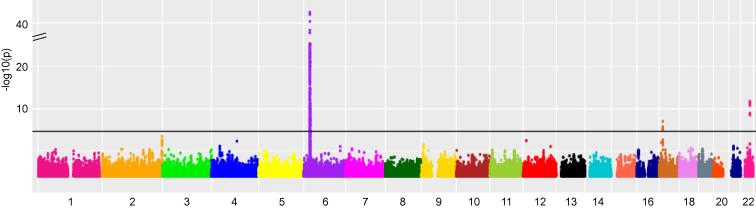
Manhattan plot illustrating genetic variants associated with liver iron in UK Biobank. The x-axis is the chromosomal position and y axis is -log(P) for the association with each variant. The black line indicates genome-wide significance level (5 × 10−8). SNPs, single-nucleotide polymorphisms.